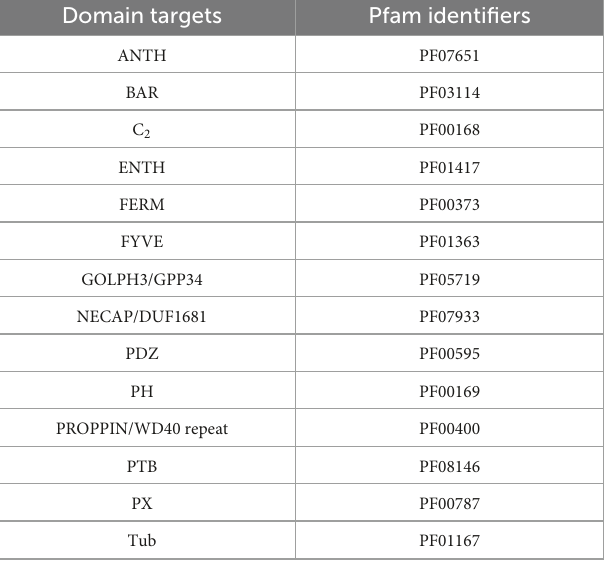
TABLE 5 The domains targeted to provide complete coverage of the proteins that act upon the PI pathway (PIP-binding proteins). Domain